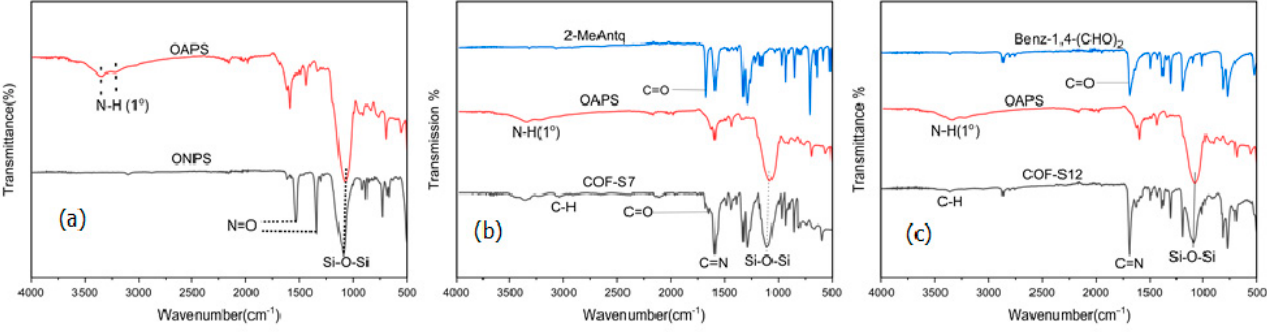
Figure 3. Stack plot comparing, ( a ). (black) ONPS and (red) OAPS ( b ) the FTIR spectra of as- synthesized (black curve) COF-S7, (red curve) OAPS and (blue curve) 2-MeAQ ( c ) (black curve) COF-S12, (red curve) OAPS, and (blue curve)